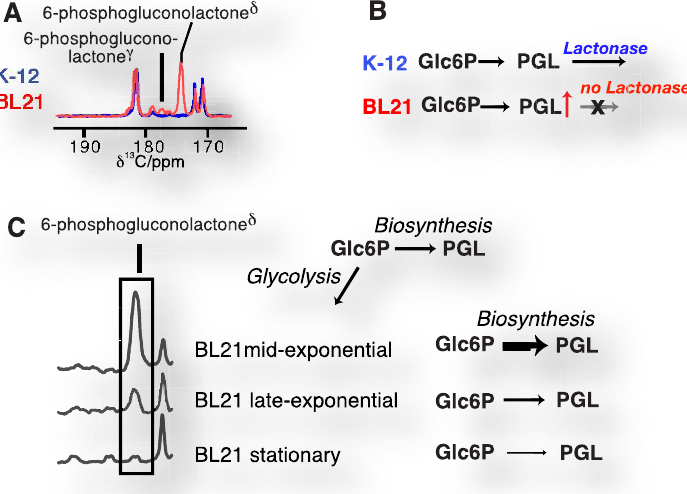
accumulation of a lactone intermediate of the pentose phosphate pathway in strain BL21 ( A , B ) due to the absence of the lactonase in the BL21 genome, thus affording genomic probing by direct observation of intracellular reaction kinetics; Glc6P = glucose 6-phosphate; PGL = 6-phosphogluconolactone. ( C ) Accumulation of the lactone occurs in a growth phase dependent manner due to reduced usage of a hyperpolarized glucose probe in biosynthetic pathways as cells approach the stationary